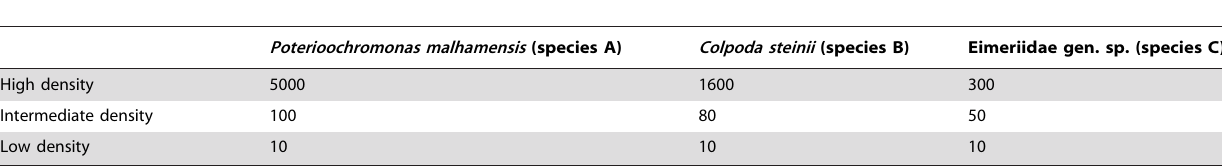
Table 1. Abundances of the three protozoan species in 0.50-mL aliquots of stock cultures (used for introduction of protozoans into the microcosms) in medium inoculated with bacteria.